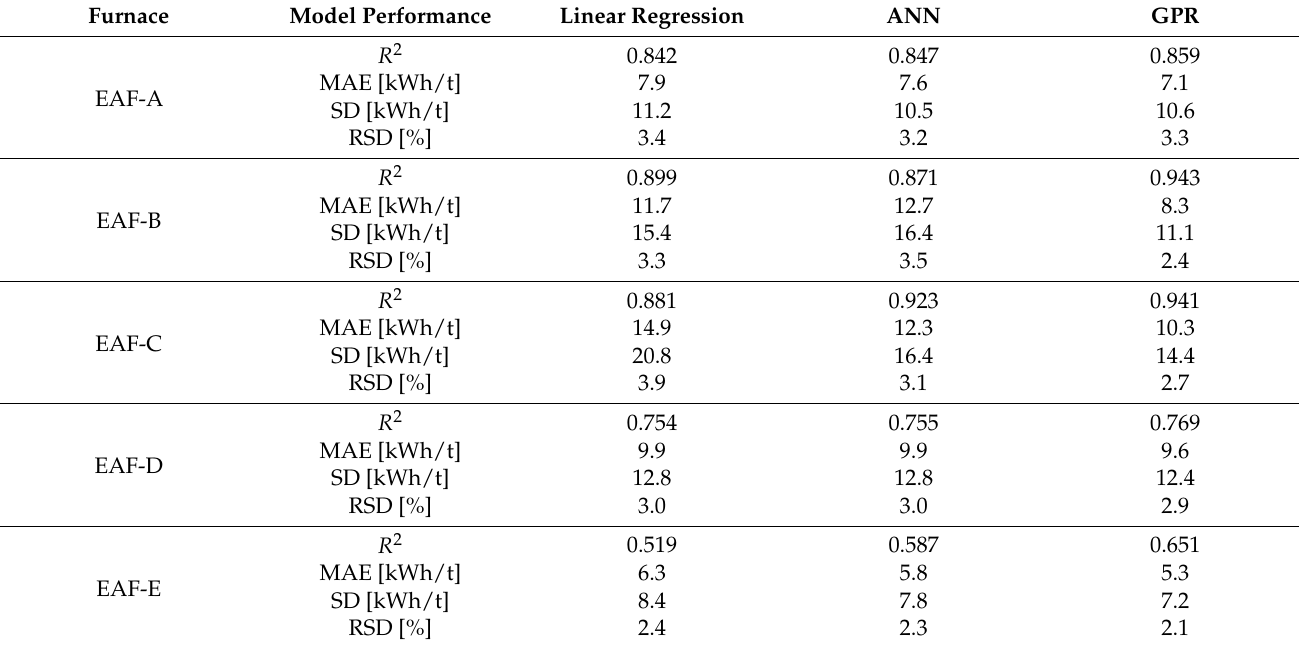
Table 5. Median result of the applied regression algorithms on the entire data set for validation. Furnace Model Performance Linear